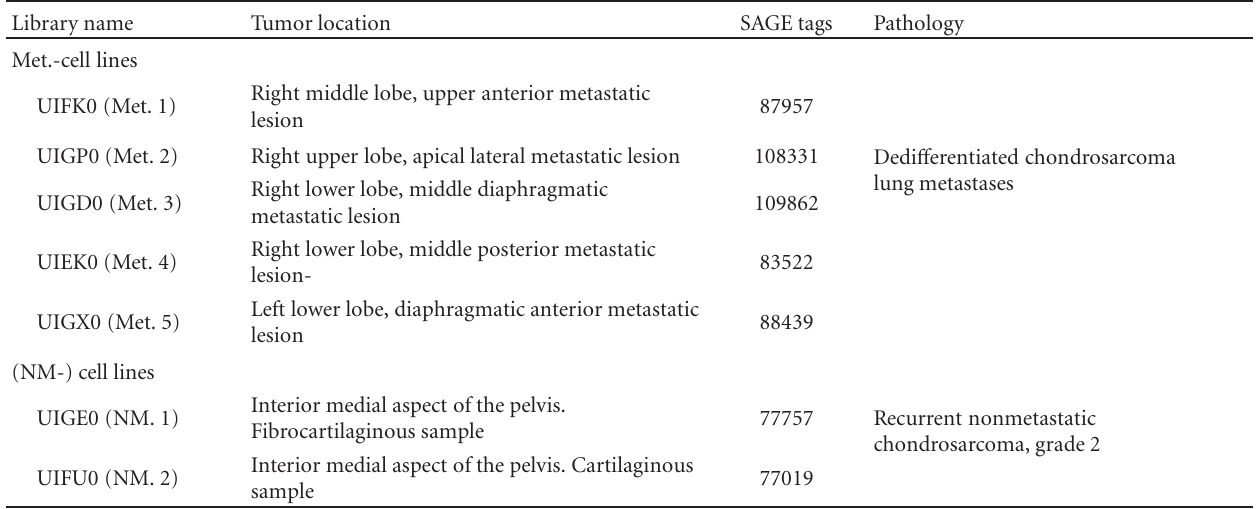
Table 1: Panel of SAGE